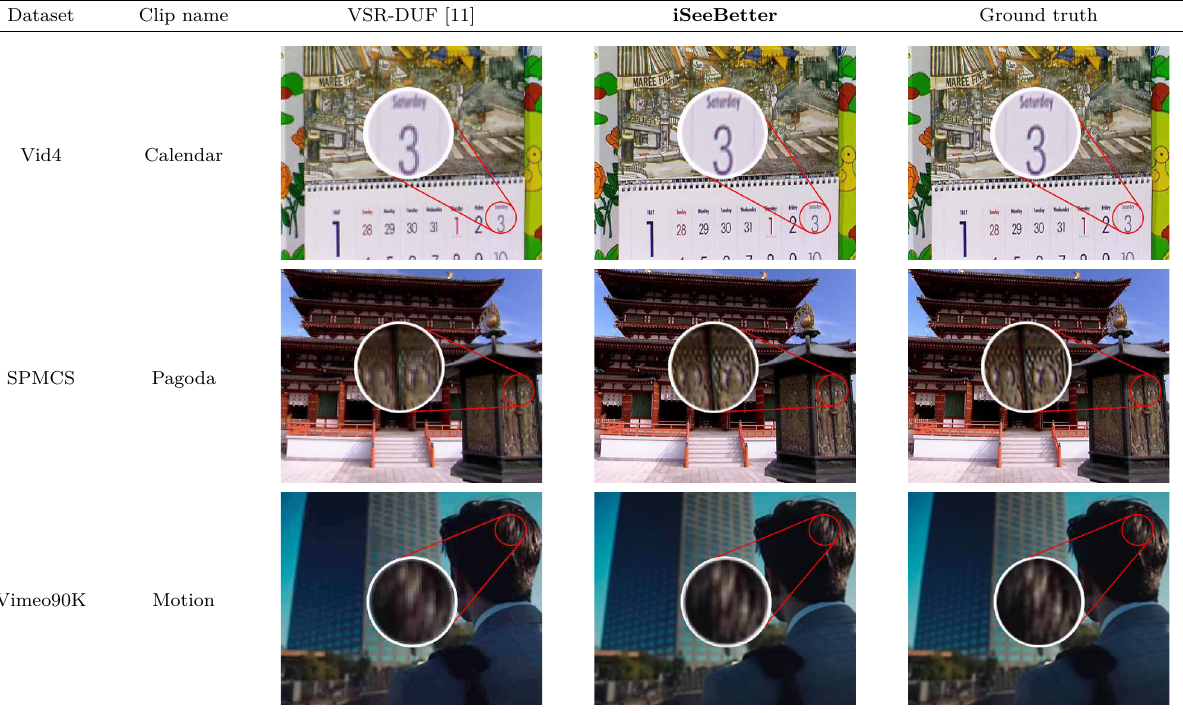
Table 4 Visually inspecting examples from Vid4, SPMCS, and Vimeo-90k comparing VSR-DUF and iSeeBetter. We chose VSR-DUF for comparison because it was the state-of-the-art at the time of publication. Top row: fine-grained textual features that help with readability; middle row: intricate high-frequency image details; bottom row: camera panning motion